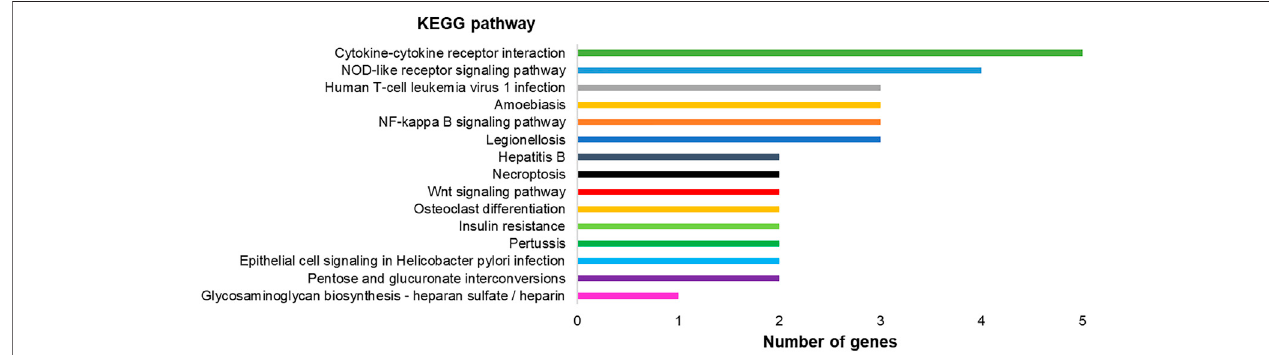
FIGURE 7 | Graph representing KEGG pathways associated with the differentially expressed genes in hPLF after immortalization processes and their respective number of genes found in the transcriptome analysis.